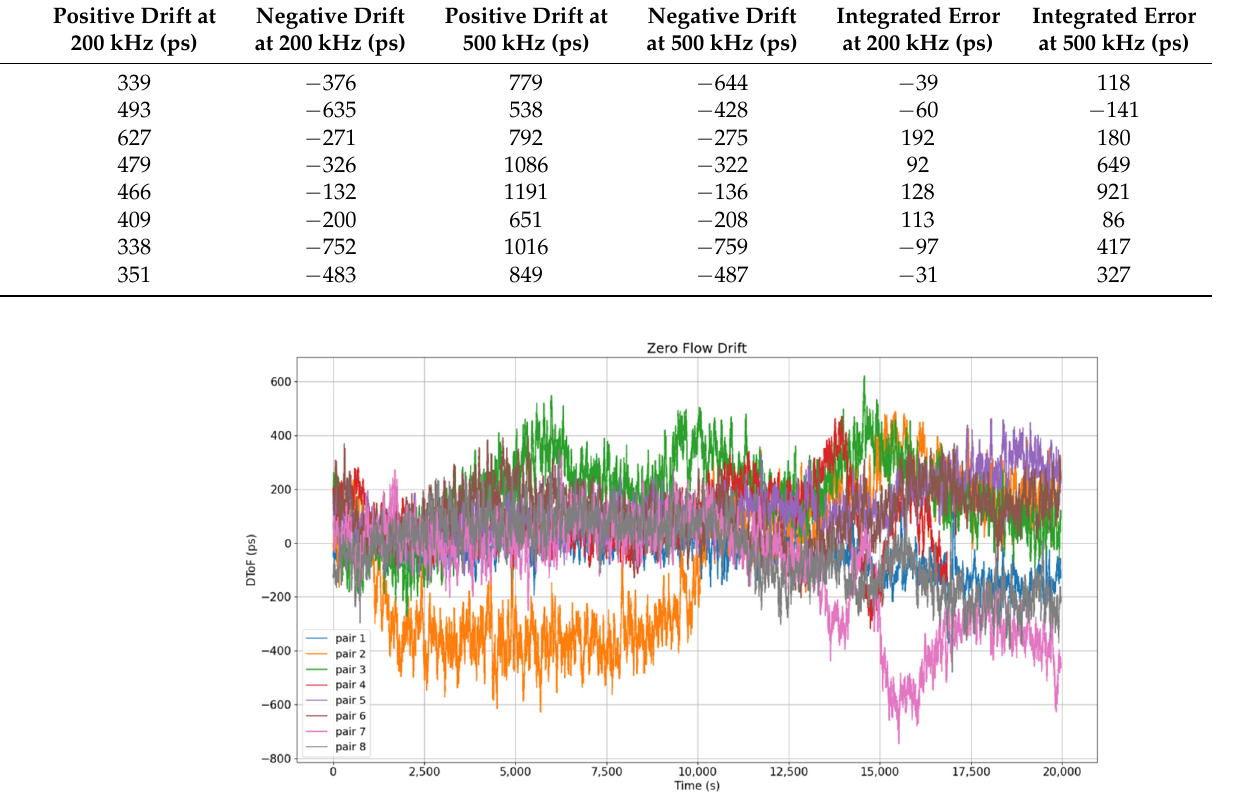
Figure 12. Zero-flow drift of 200 kHz transducers.